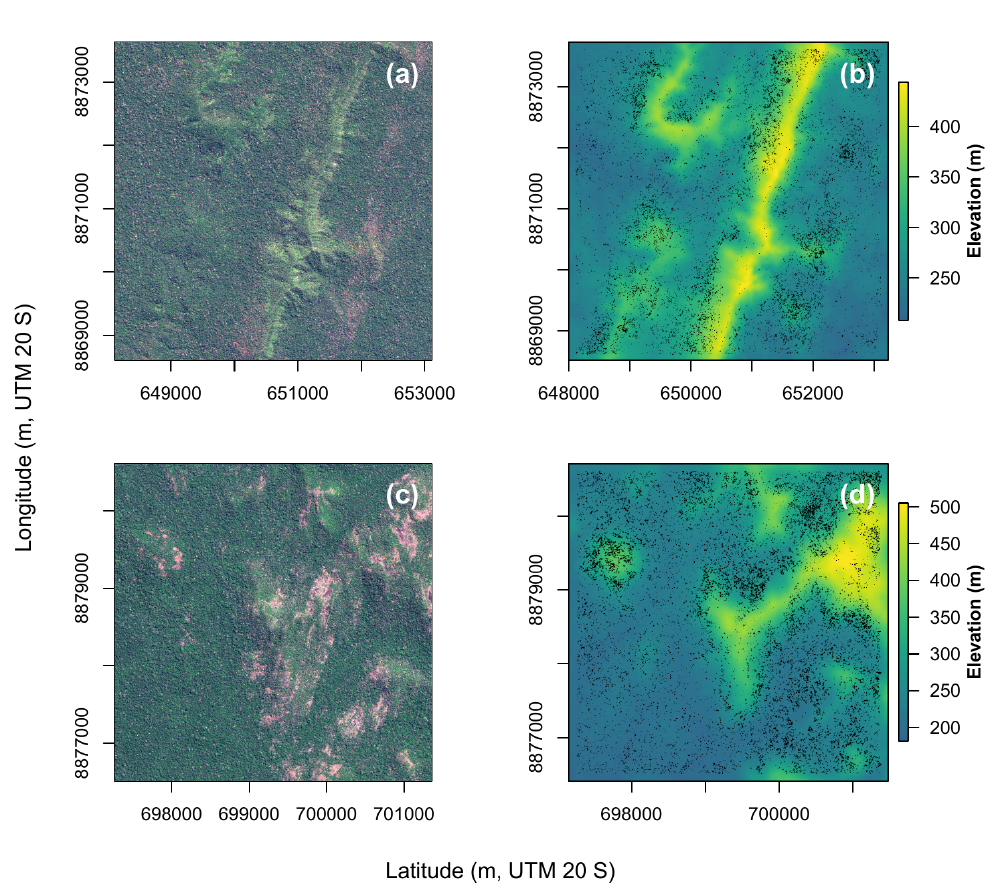
Figure 9. RGB images and canopy palm distribution mapped with the U-net model for the region 8 ( a , b ) and region 9 ( c , d ), both near high elevation.